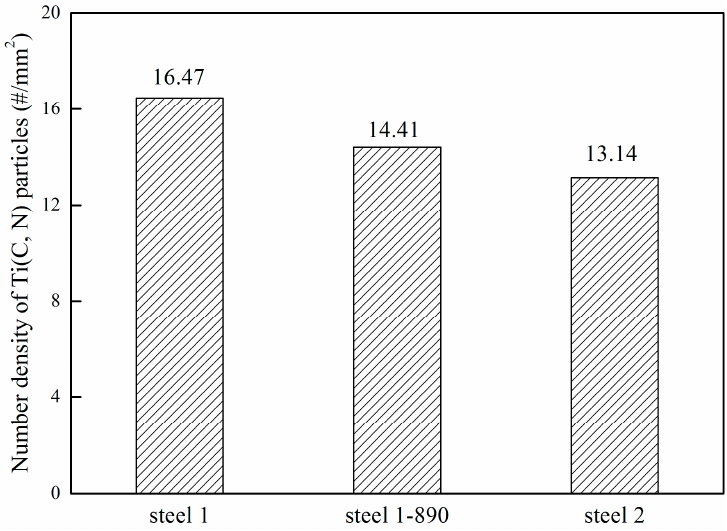
Figure 11. Number density of Ti(C, N) particles in specimens.